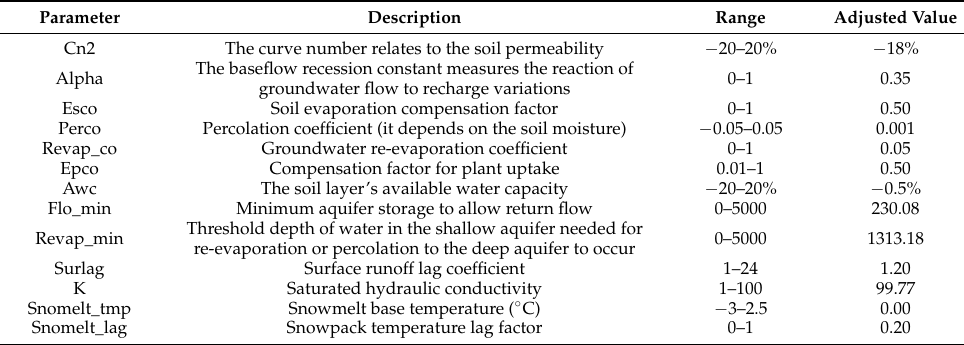
Table 1. Description, range, and adjusted value for all modified parameters after calibration.